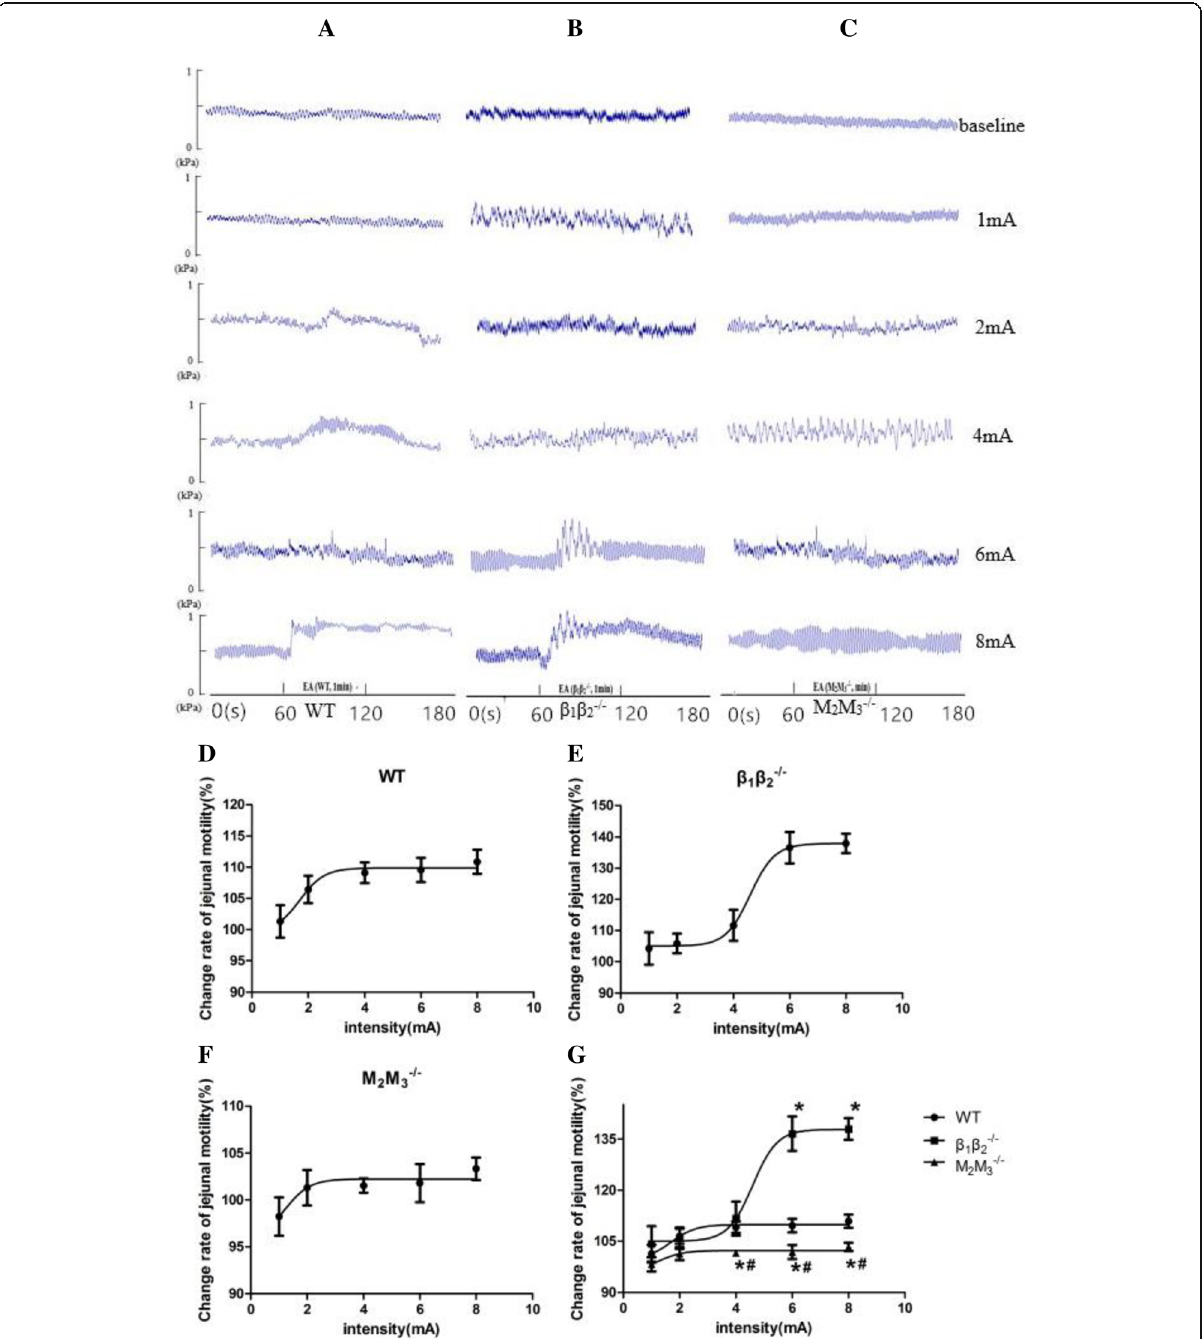
Fig. 5 The effect of different intensities of EA at LI11 on jejunal motility in WT, β 1 β 2 − / − and M 2 M 3 − / − mice. a - c Representative tracings of jejunal motility with different intensities of EA in WT, β 1 β 2 − / − and M 2 M 3 − / − mice, respectively. d - f The fitting curves of the EA effect with different intensities on jejunal motility in WT, β 1 β 2 − / − and M 2 M 3 − / − mice, respectively, showing the relationships between different intensities of EA (1, 2, 4, 6, and 8 mA) and the rate of change rate in jejunal pressure. g The integrate fitting curve showed the enhanced effect of EA with different intensities on jejunal motility in three groups. Data are expressed as mean ± SEM ( n = 8 mice). * P < 0.05 vs WT mice, # P < 0.05 vs β 1 β 2-/ − mice, independent t -test. WT,